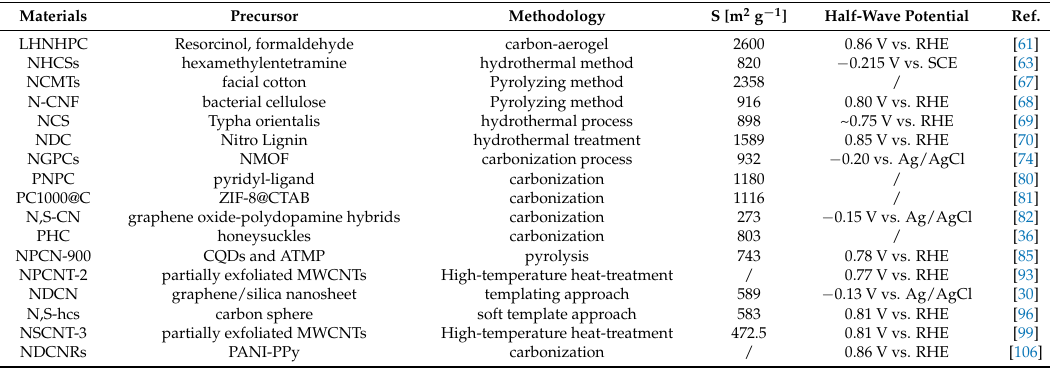
Table 1. Parameters of N ‐ doped carbon ‐ based materials applied for ORR.